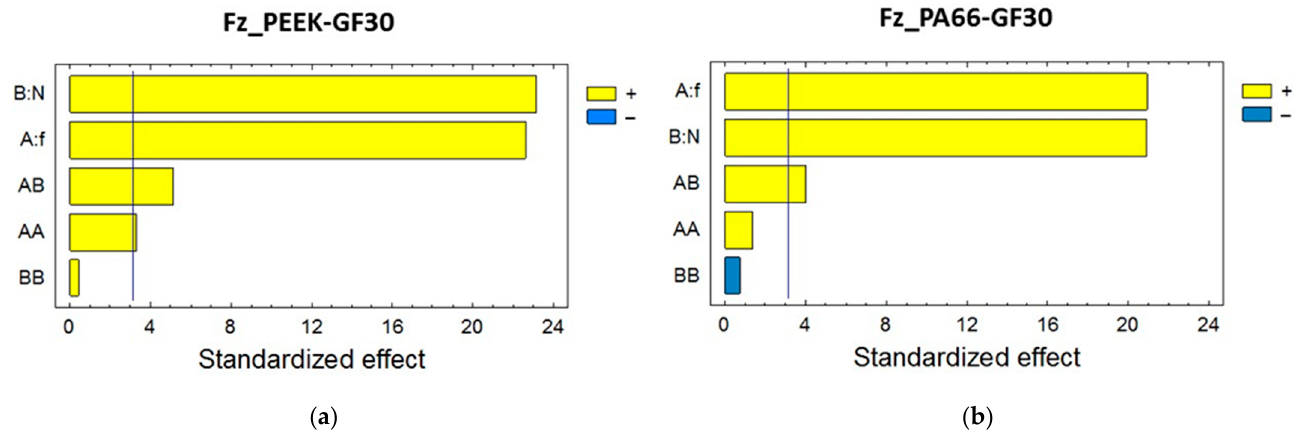
Figure 2. Standardized Pareto chart for thrust forces at a 95% confidence level: ( a ) standardized effect for Fz_PEEK-GF30 [dimensionless] and ( b ) standardized effect for Fz_PA66-GF30 [dimensionless].